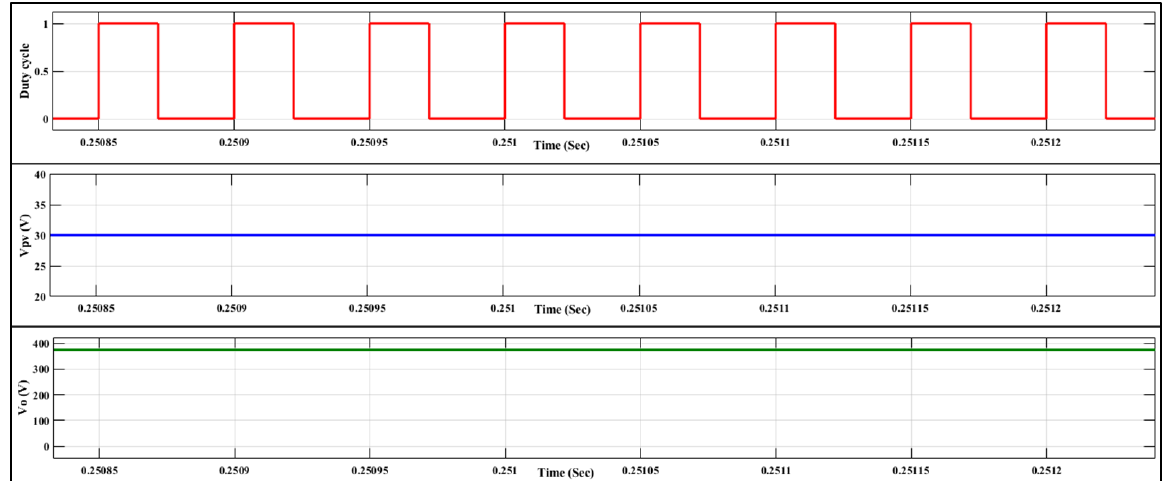
Figure 11. Simulated waveform for solar PV module output voltage (V pv ) and output voltage (V o ) of